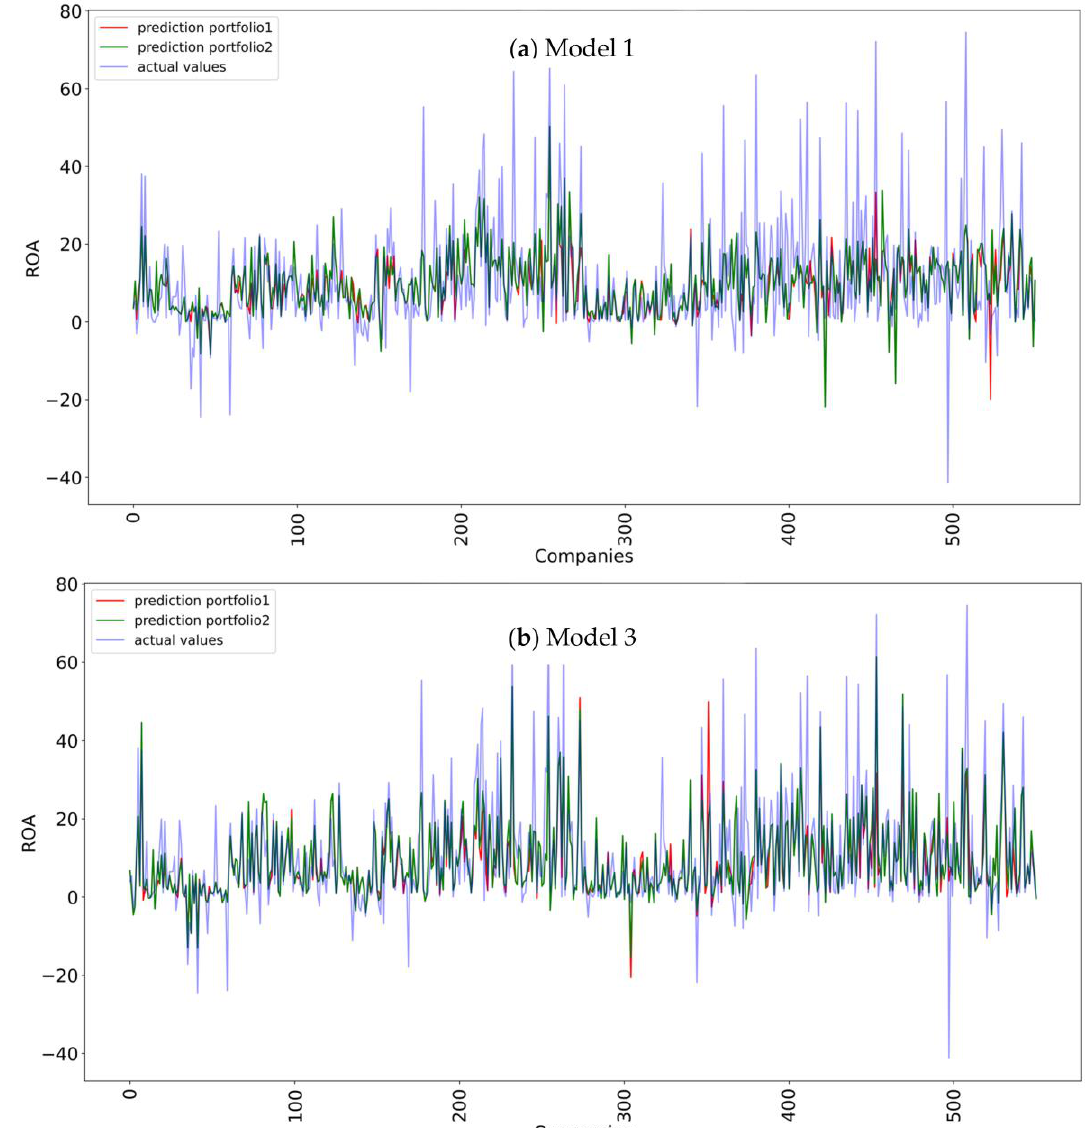
Figure 5. Actual and predicted profitability values using Portfolio 1 and Portfolio 2 for the test sample: ( a ) Model 1 and ( b ) Model 3.